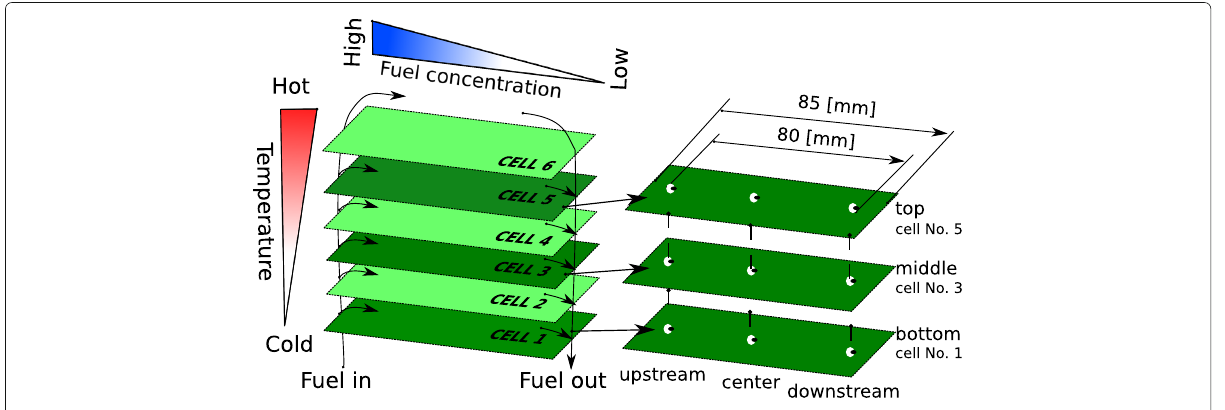
Fig. 4 The locations of the selected samples in a cell and in the stack Recently, the diffusion-based algorithms are receiving increasing attention since they do not require a constric- tion factor. This is because the bottlenecks and the bulges are directly taken into account during the simulation of the diffusion process and the measured value is a direct reduction of the diffusion coefficient [34].